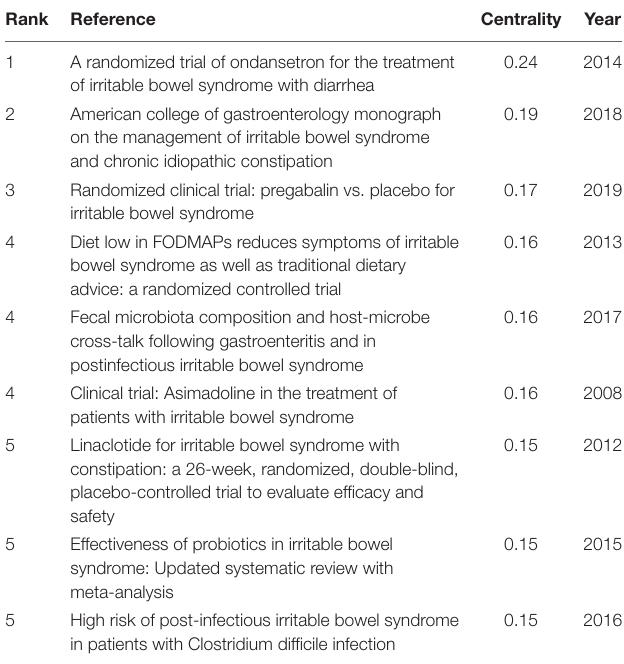
TABLE 5 | Top 5 co-cited references with the highest betweenness centrality in IBS